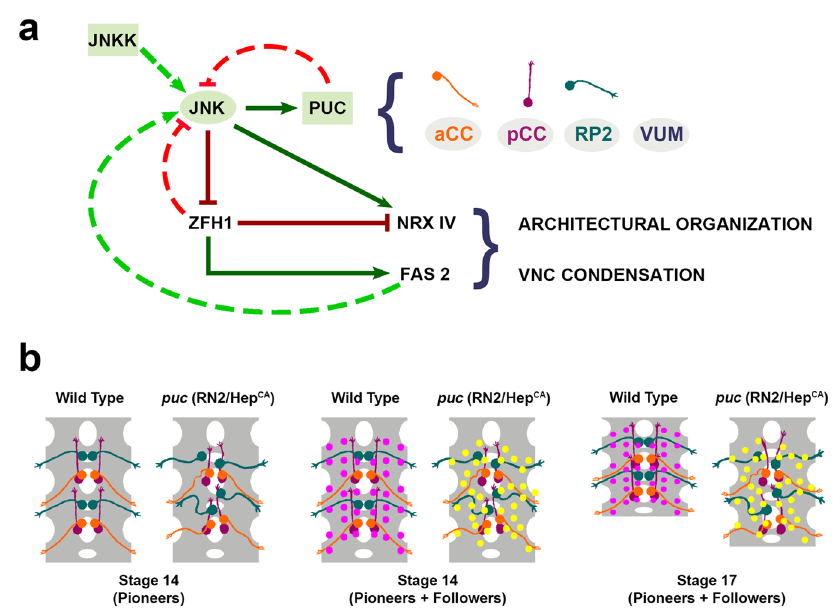
Fig.6|JNKsignalingmodulatestheexpressionofZfh1,whichfeedbacksonJNK activity and affects Fas 2 and Nrx IV expression. a Maximum projection of the VNC of a stage 16 zfh1 embryo stained with Fas 2. Anterior is up. Scale bar 10 μ m. b Self-cross-correlation matrixof the Z sections of ( a ) along the AP axis.Scalesand colormap as in Fig. 1. Nodes are sustained but structural noise increases dramati- cally. c Image cross-correlation score along the AP axis for ( b ) ( n =8 embryos). 3D nodes fall 33 μ m apart and the internodal correlation fl attens. The grey lines show individual pro fi les, black averaged values and red ± SD. Green bars indicate max- imum correlations (3D nodes). d zfh1 / + and e) zfh1 stage 16 embryos Fas 2 immunoreactivity. Maximum projection of ventral views across three abdominal segments.Overlaidsquares[nodes(magenta)andinternodes(yellow)]aretheROIs employed on Average Integrated Density measurements. Scale bar 10 μ m. f Average Integrated Density at nodes and internodes (magenta and yellow peri- meters) for ( d ) (grey) (Nodes, n =41; Internodes, n =44) and ( e ) (dark yellow)